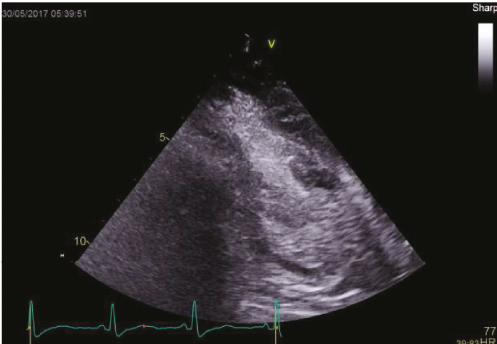
Figure 1: Left ventricular view of the thrombus at the apex of the left ventricle.